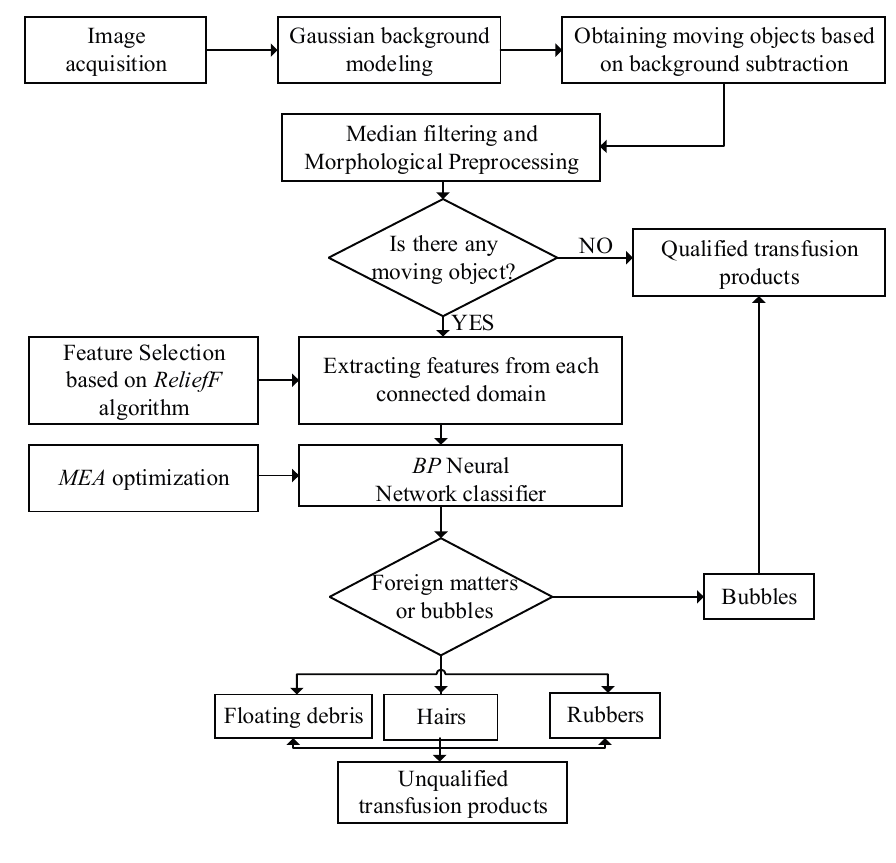
Figure 2. Detection and identification flowchart of foreign matter in transfusion. MEA, mind evolutionary algorithm; BP, back propagation.